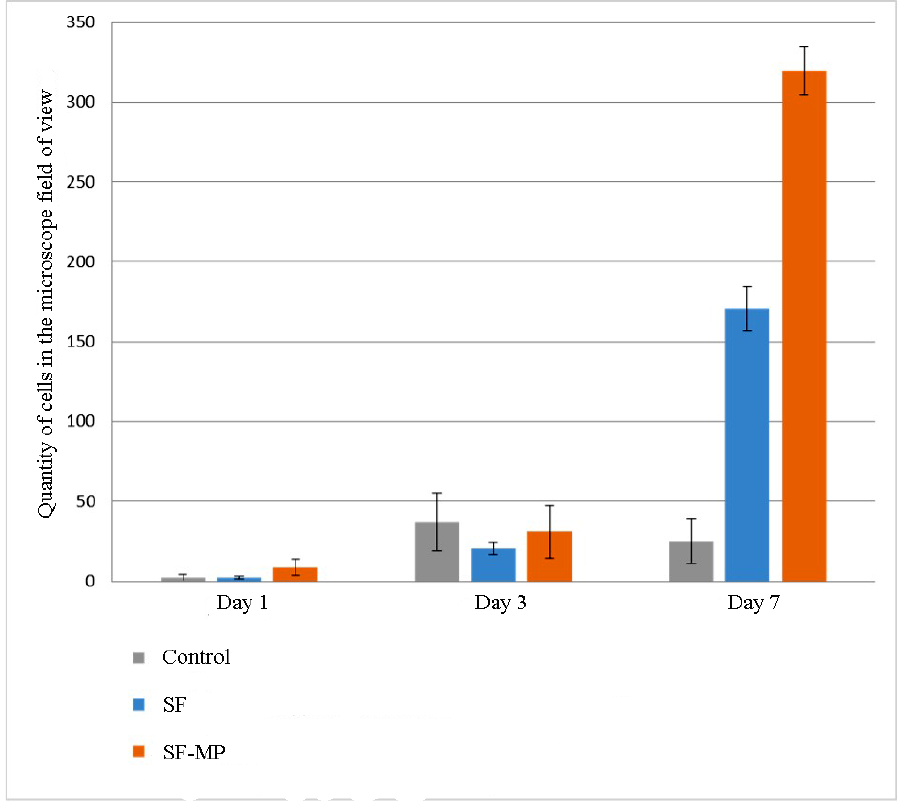
Figure 9. Data on the proliferative activity of 3T3 culture cells on days 1, 3, and 7 of the experiment on the obtained scaffolds based on silk fibroin. Standard deviation values for five independent measurements are shown.